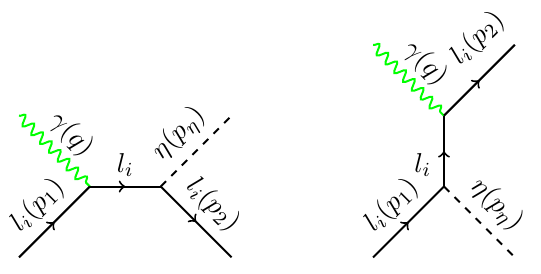
Figure 9 . Diagrams (a) and (b) contributing to the (cid:13)l i ! (cid:17)l i process.